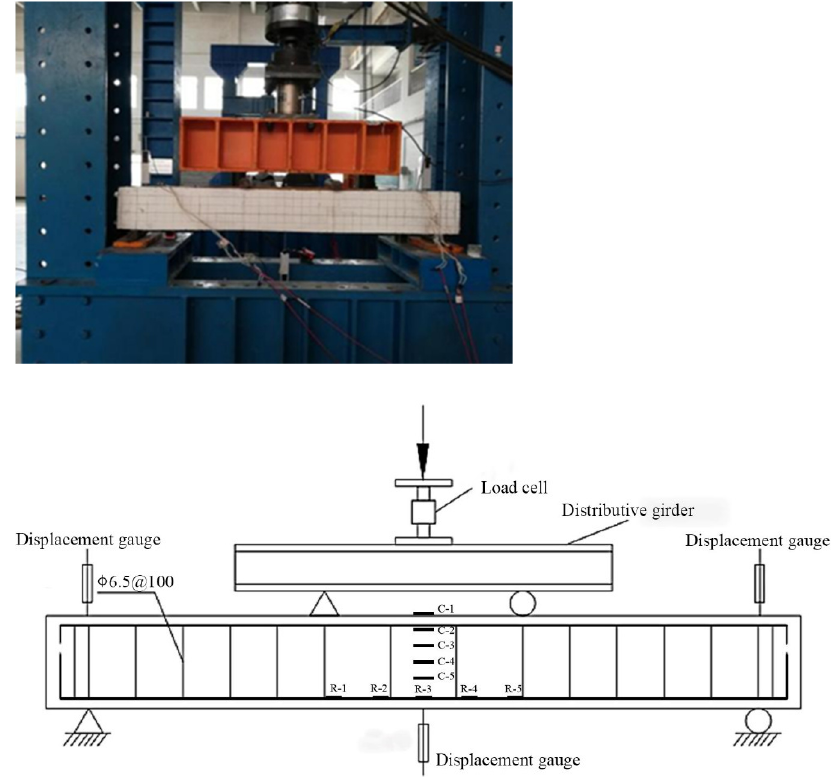
Figure 3. Schematic diagram of test device and loading.